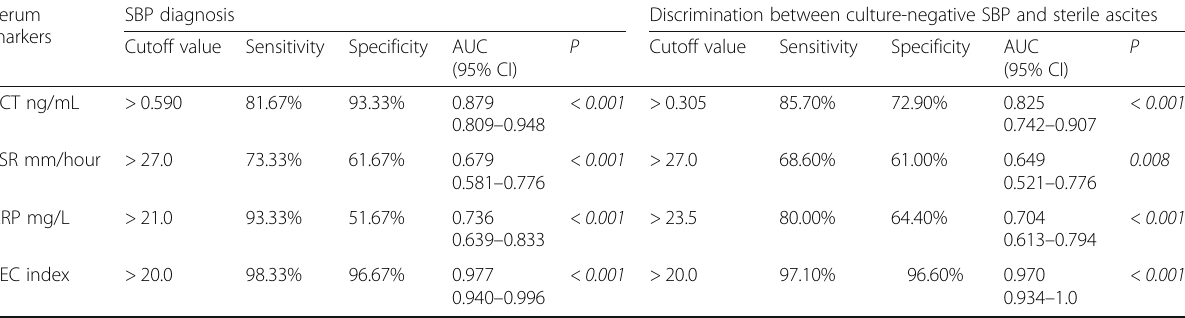
Discrimination between culture-negative SBP and sterile ascites